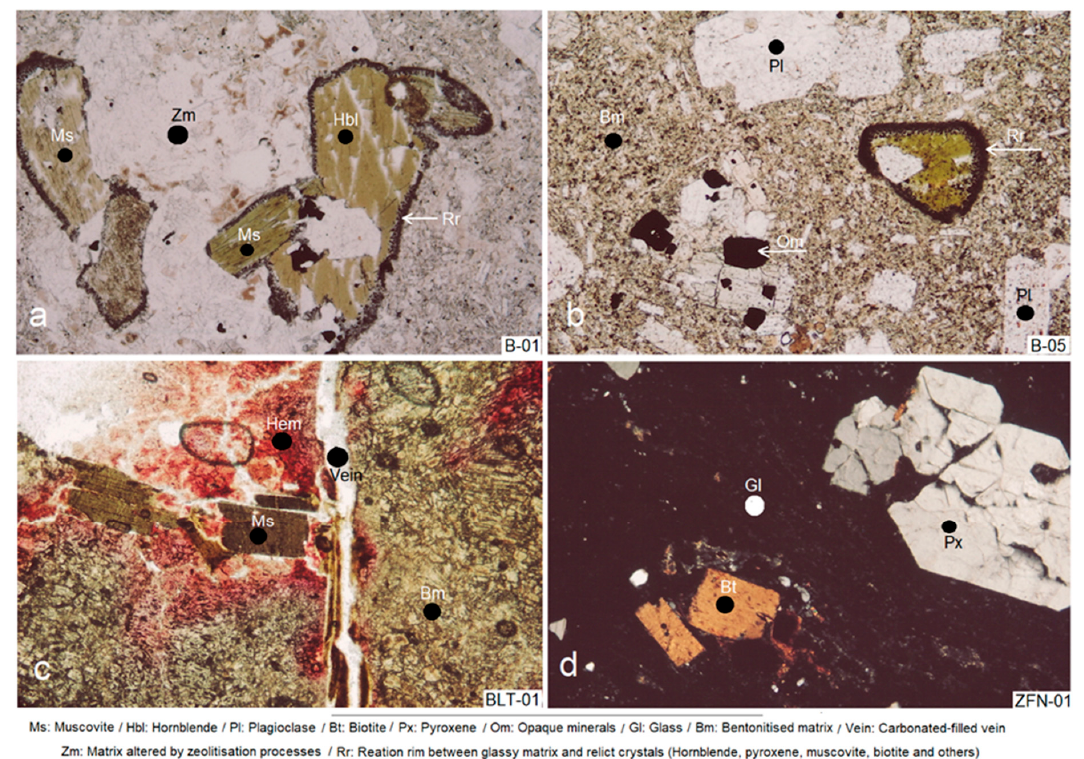
Figure 5. Petrographic thin section micrograph of bentonite samples from San José–Los Escullos deposit. N// (parallel nicols, ( a , b )) and Nx (crossed nicols ( c , d )).